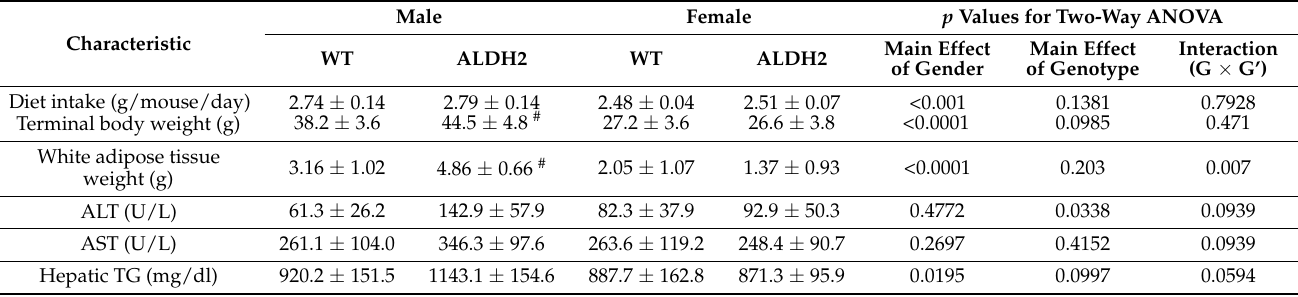
Table 2. Basic physiological value, liver injury index, and concentration of hepatic triglycerides of WT and ALDH2 mice fed an